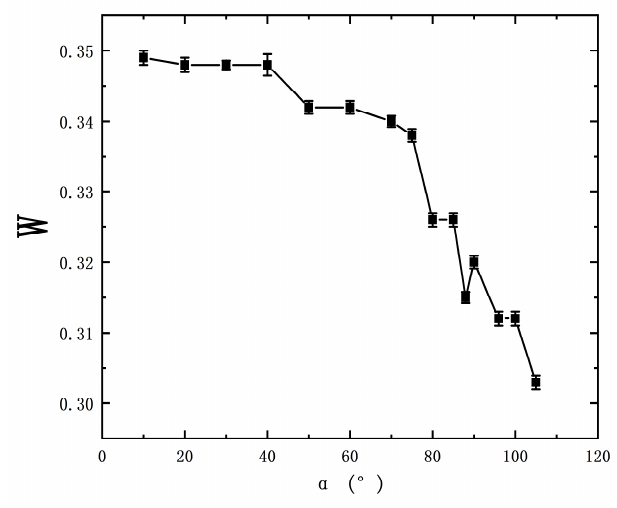
Figure 6. The transmission probability W versus α.